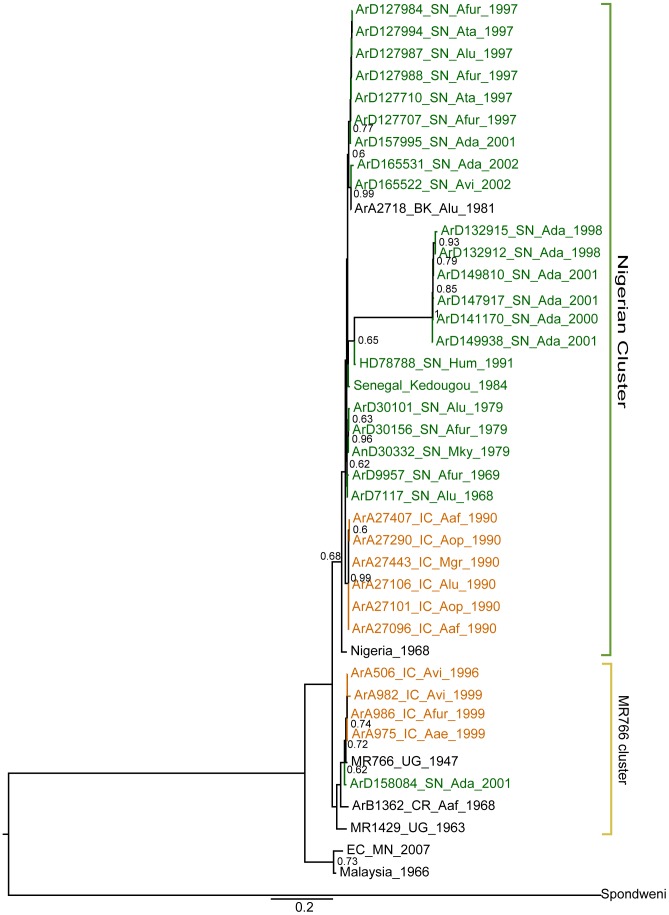
Maximum likelihood phylogenetic tree inferred for concatenated of sequences from Envelope and NS5 genes of Zika virus.Consensus tree summarized after 1000 non-parametric bootstrap replicates, with support values greater than 60% shown in the nodes. The cluster the Ugandan MR766 prototype strain was highlighted by the yellow sector and the Nigerian cluster was highlighted by the green sector. The strains from Senegal and Côte d'Ivoire are shown in green and orange, respectively. The tree has been rooted with the Spondweni lineage isolated in South Africa was used as outgroup to root the tree.